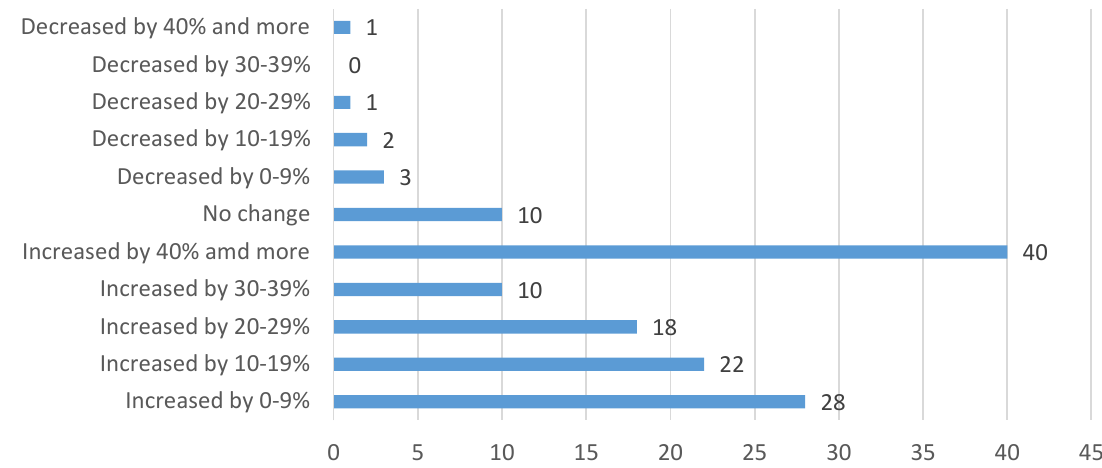
Figure 4. Comparing expected change in banks’ AML compliance costs in 2016,